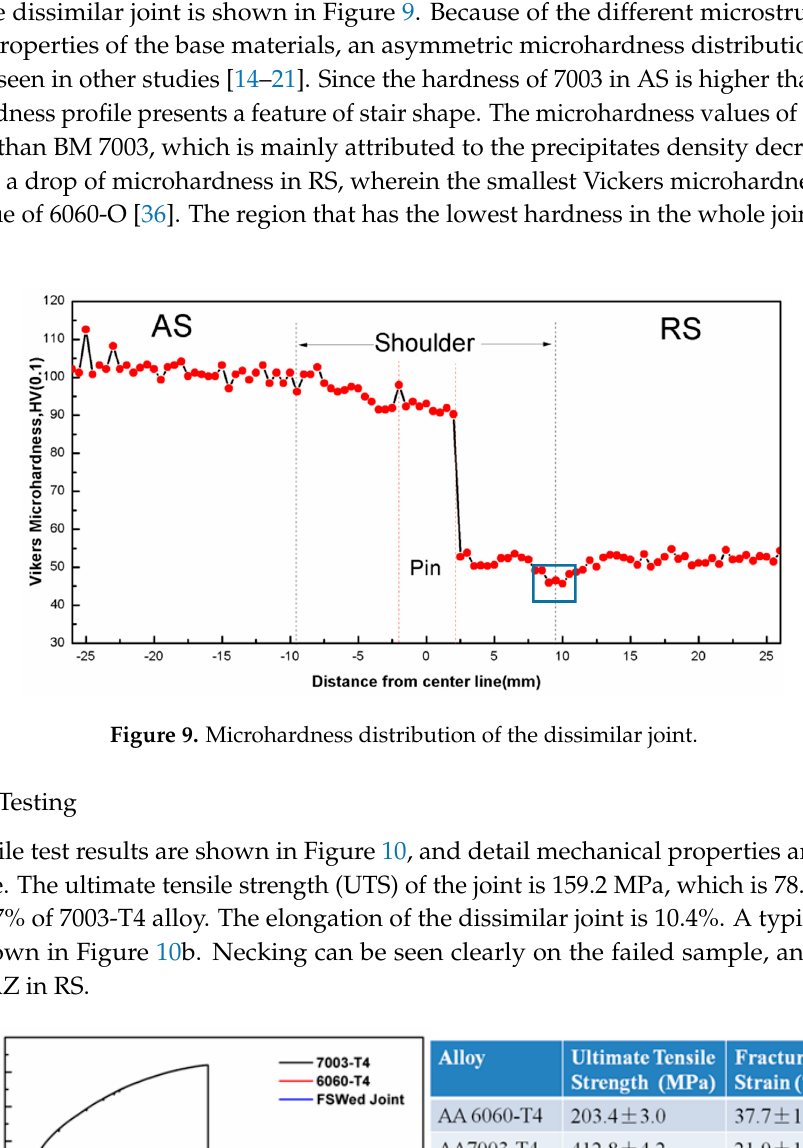
Figure 8. TEM of ( a ) HAZ and ( b ) TMAZ in retreating side (RS).